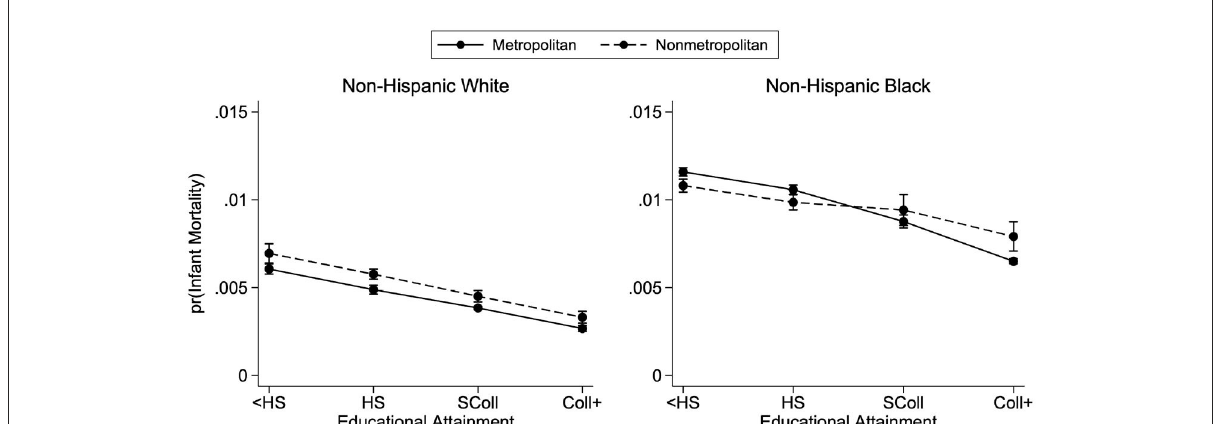
FIGURE7 Predicted probabilities of infant mortality by metropolitan residence and race, 2011–2015, state subsample. Educational gradients of infant mortality by race and metropolitan residence for states that had adopted the 2003 revised birth certificate form before 2011. Births occurred between 2011 and 2015. Supplementary Table 5 has full regression results from which the predicted probabilities are calculated. See Figure 1 for complete figure notes and Figure 6 for states included in subsample.